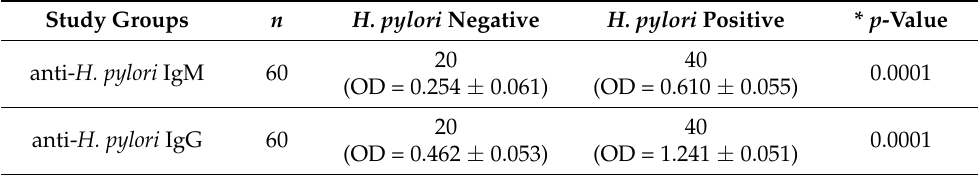
Table 2. The level of anti- H. pylori GE IgM and IgG (U/mL) in guinea pig sera.